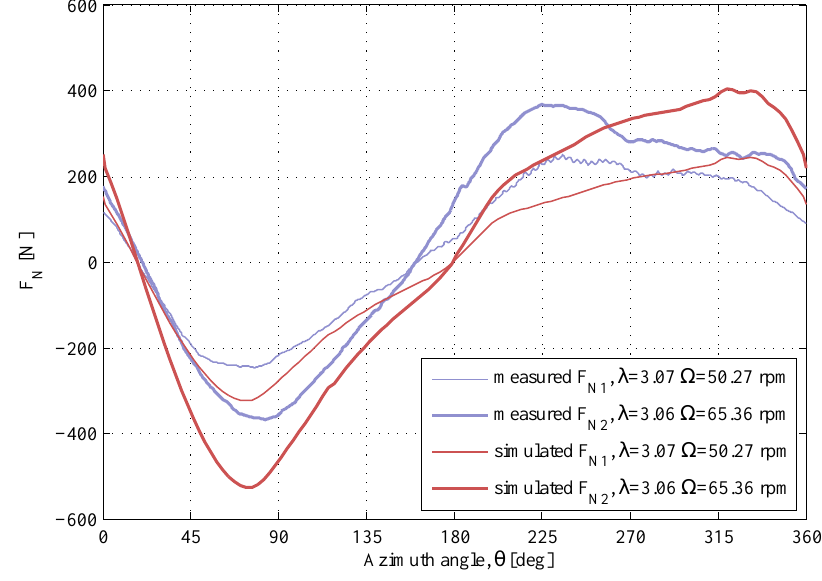
Figure 12. The normal forces at similar λ and different Ω . The air densities and the kinematic = 1 . 27 kg / m 3 , ρ = 1 . 24 kg / m 3 and ν viscosities are ρ 1 2 10 − 5 m 2 / s